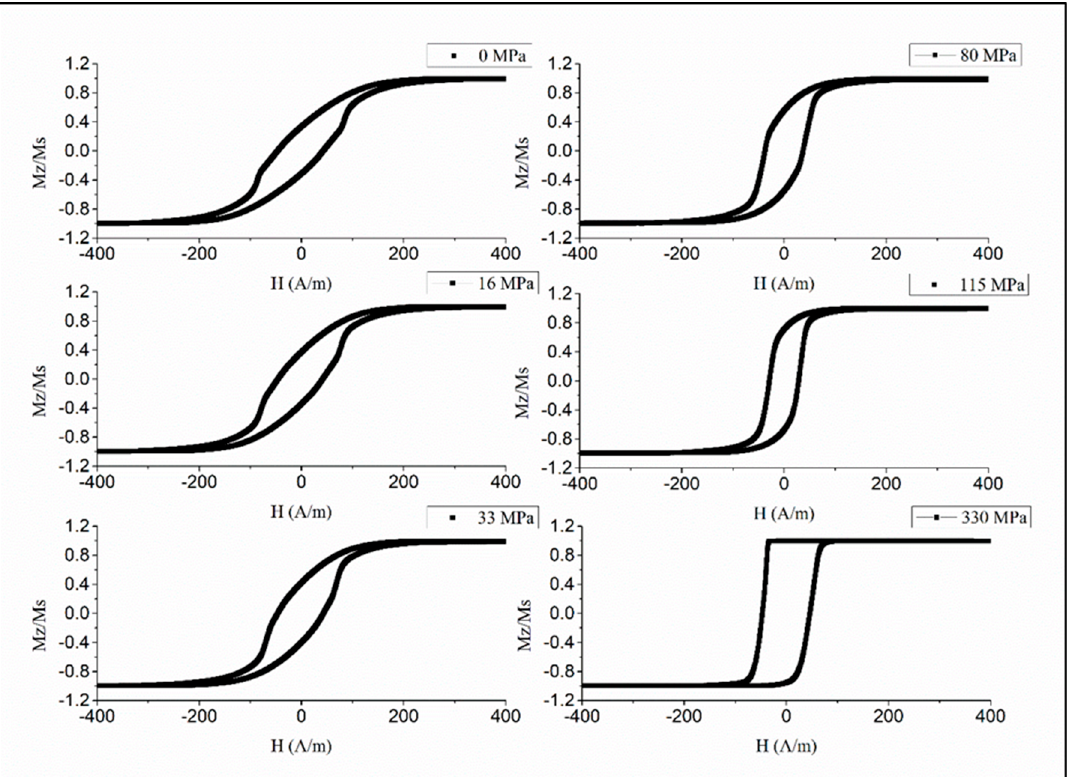
Figure 7. Effect of tensile stress on the hysteresis loops of glass-coated amorphous Co 71 Fe 5 B 11 Si 10 Cr 3 microwires after current annealing (at 60 mA (122 A/mm 2 ) for 60 min).